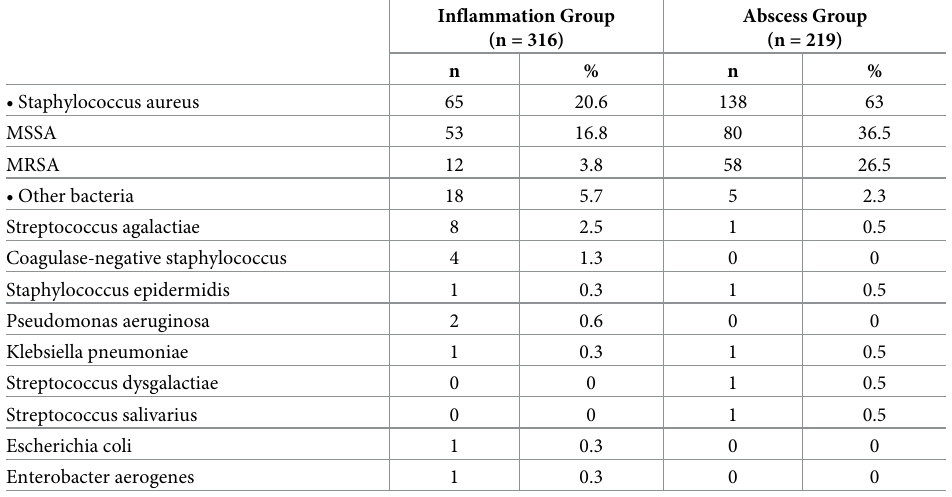
Table 1. Bacterial cultures were obtained from the breast inflammation group and the breast abscess